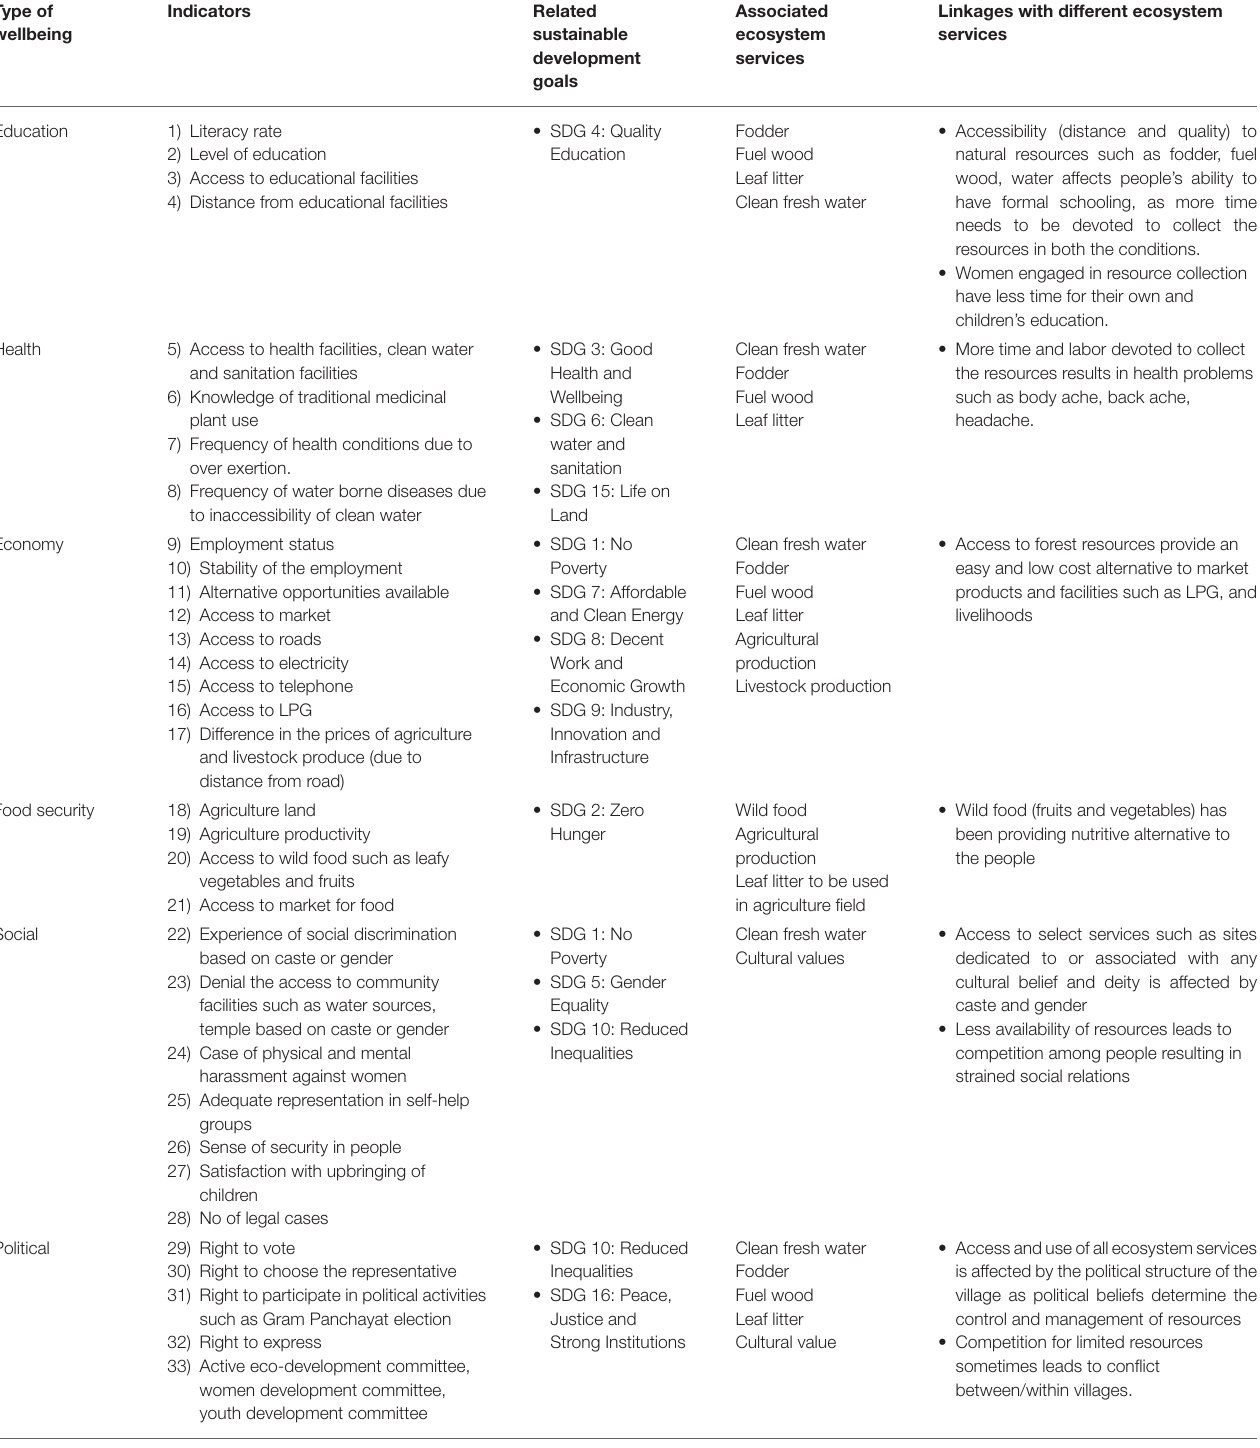
TABLE 1 | Indicators used to develop wellbeing index for forest dependent communities from Nanda Devi Biosphere